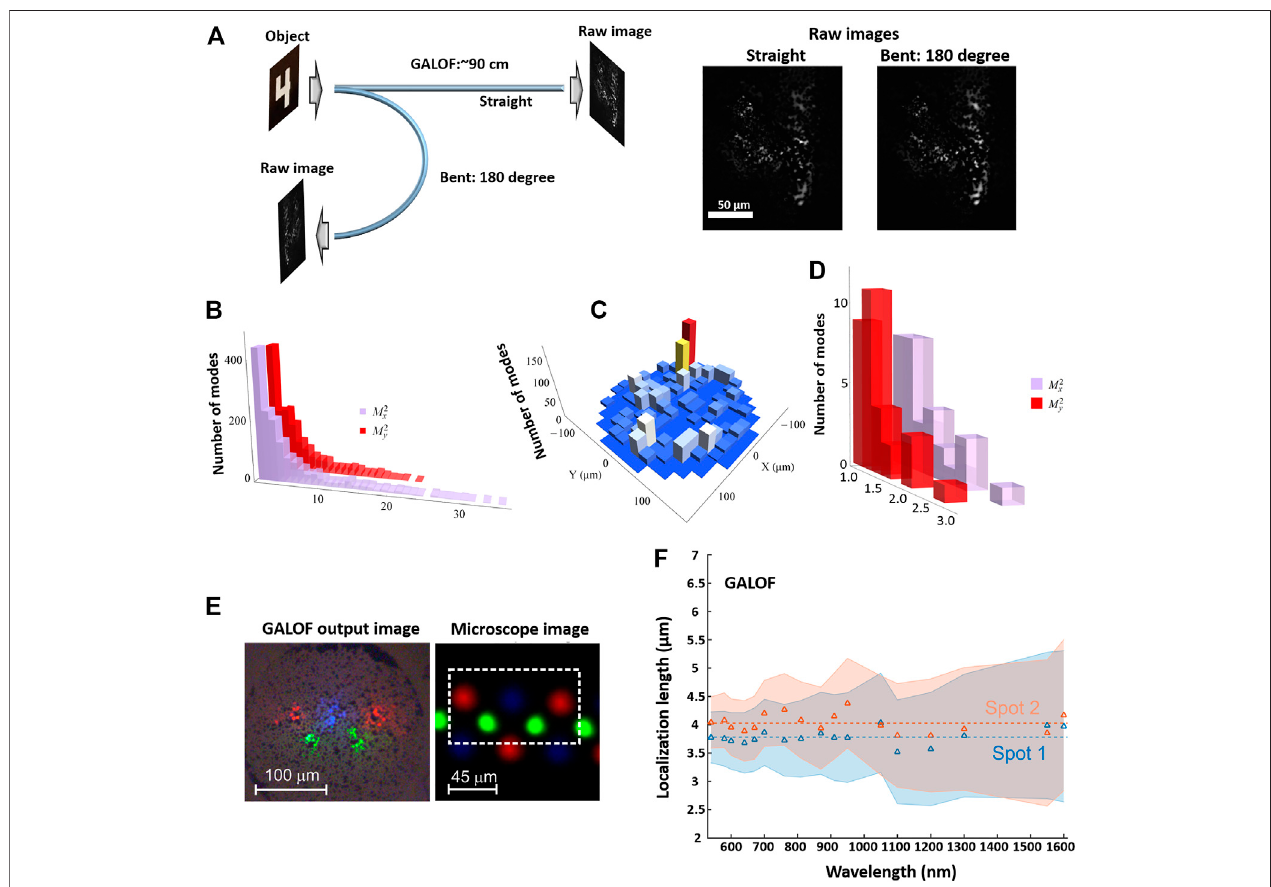
FIGURE4|(A) Imagesofdigit “ 4 ” fromgroup3onthe1951USAFresolutiontestchartaretransportedthrougha90-cm-longGALOFsampleforbothstraightand bentstatus, (B) HistogramofnumericallycalculatedM 2 valuesfor1,500localizedmodesinarealGALOFsample.Theverticalaxisrepresentsthetotalnumberofmodes fordifferentM 2 values, (C) Numericallycalculateddensityhistogramofthepositionsofthemodesin (B) intheGALOFcross-section.Thevalueofeachpixelcorresponds to the number of localized modes, (D) Histogram of M 2 values for 30 localized modes measured in the experiment, (E) Near fi eld image of the smartphone screen pixels after being transported through a 27 cm-long GALOF. The microscope image shows the pixel arrangement that is imaged onto the input facet of the GALOF. (F) LocalizationlengthobtainedfromthetransmittedbeamattheGALOFoutputfacetvs.wavelengthfortwodifferentspots.Theshadedareasindicatetheuncertainty.The two dashed lines correspond to the averaging values of the measurements for each output spot, (A – D) are adapted with permission from [103] © The Optical Society. (E,F) are adapted with permission from [48].